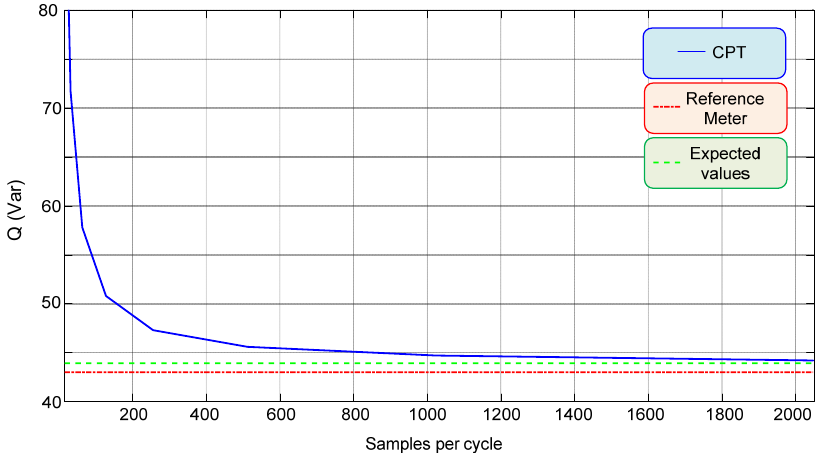
Figure 6. Reactive power for the inductive load with two resistive loads in parallel.